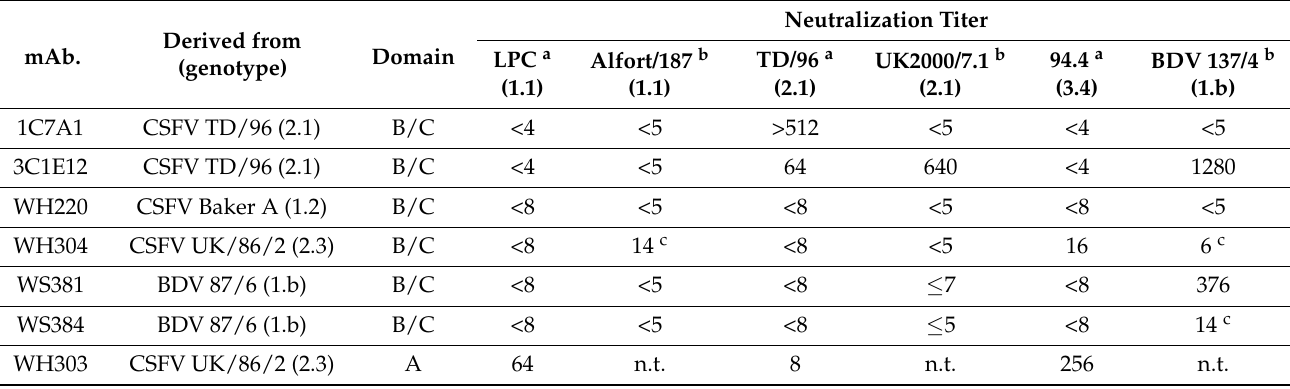
Table 3. Virus cross-neutralization titers of E2-specific